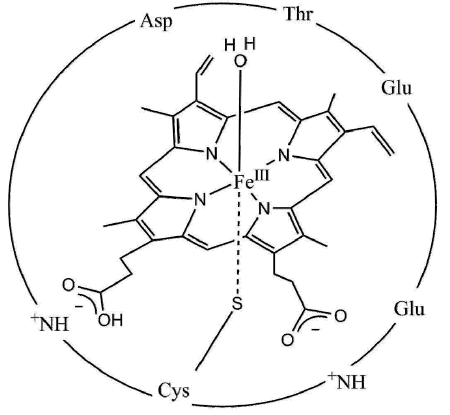
Figure 2. The active site of P450 [81].